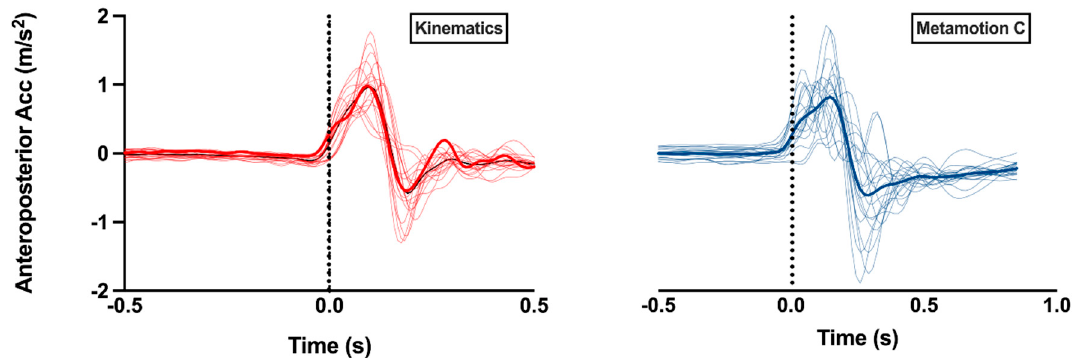
Figure 3. COM anteroposterior acceleration of each subject and the average of all subjects in the first session. Thick red and blue lines represent the average recording resulting from the 20 subjects (in each device. Thin lines represent individual recordings. The dotted line represents the moment of impact of the pendulum. Acc: acceleration.